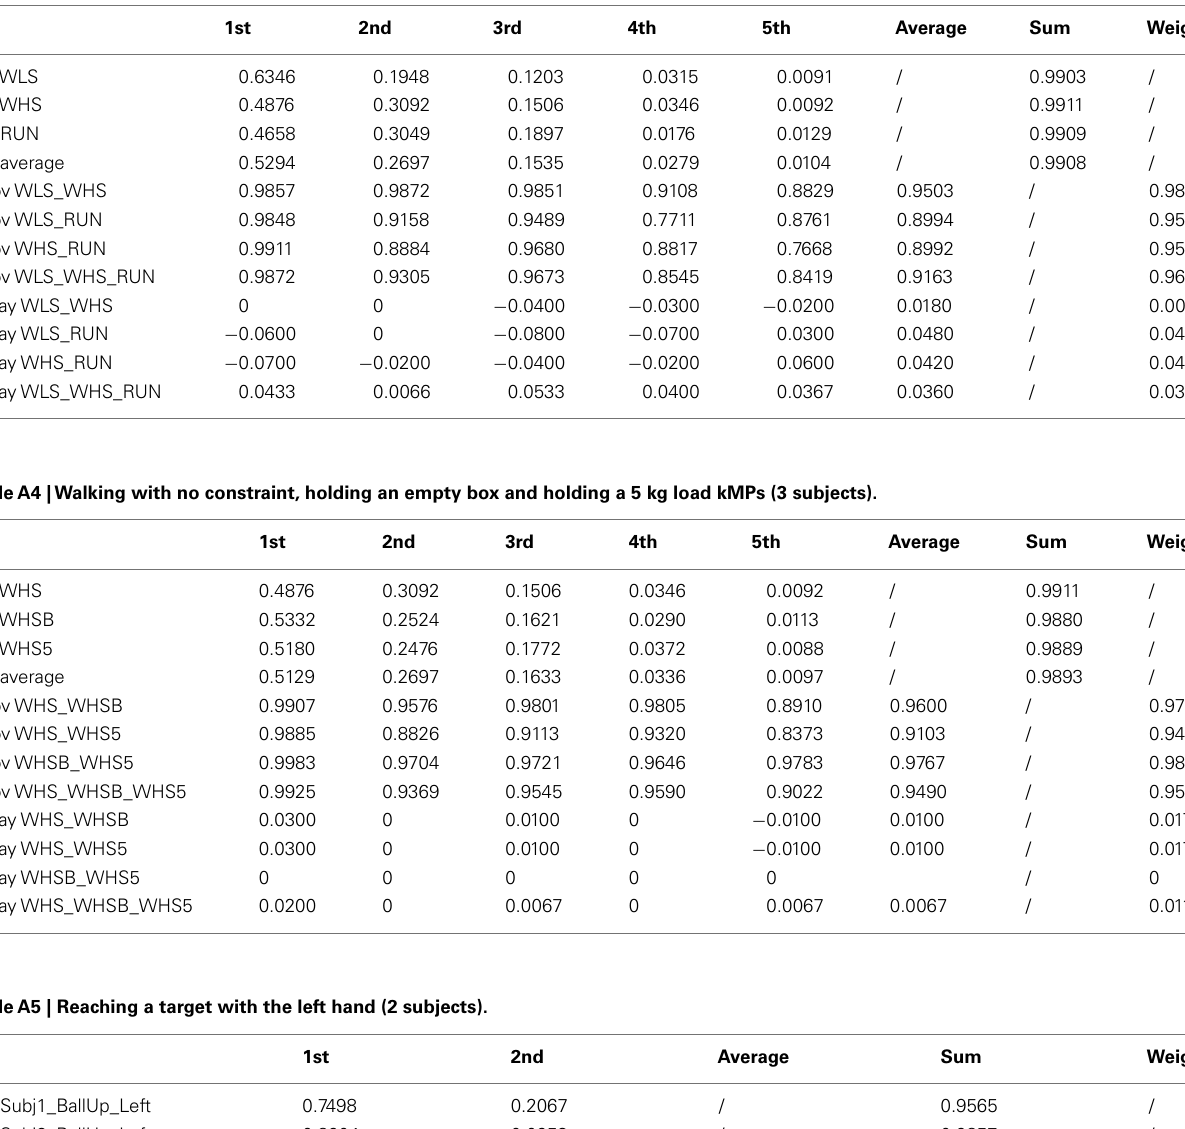
TableA3 |Walking at low and high velocity and running kMPs (3 subjects).